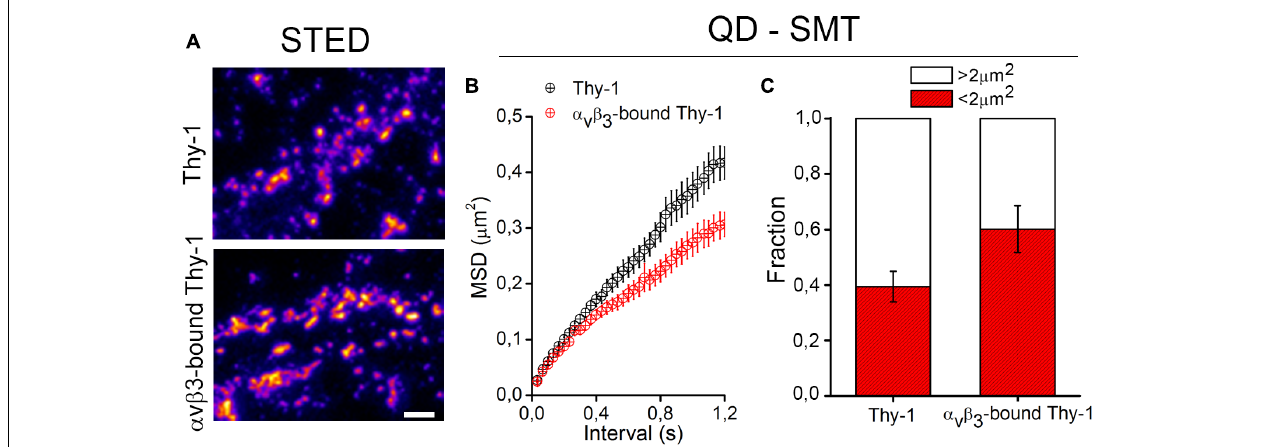
FIGURE 1 | Changes in clustering and confinement of Thy-1 induced upon α v β 3 integrin binding in the neuronal membrane. (A) As shown in Maldonado et al. (2017), cultured rat neurons were treated with a soluble form of the α v β 3 integrin, fixed with 4% PFA for 8 min, and stained with a mouse monoclonal anti-Thy-1 antibody (clone OX-7) followed by Atto647N-conjugated secondary antibodies. Then, Thy-1 nanoclusters were visualized using a super-resolution stimulated emission depletion (STED) microscope. (B,C) Single molecule tracking (SMT) of Thy-1 molecules attached to quantum dots (QD) is described in Maldonado et al. (2017). Further analysis of mean square displacement (MSD) (B) and the total fraction of molecules moving in areas with 2 µ m 2 or more (C) confirmed that binding of α v β 3 integrin decreases the lateral mobility and increases the confinement of